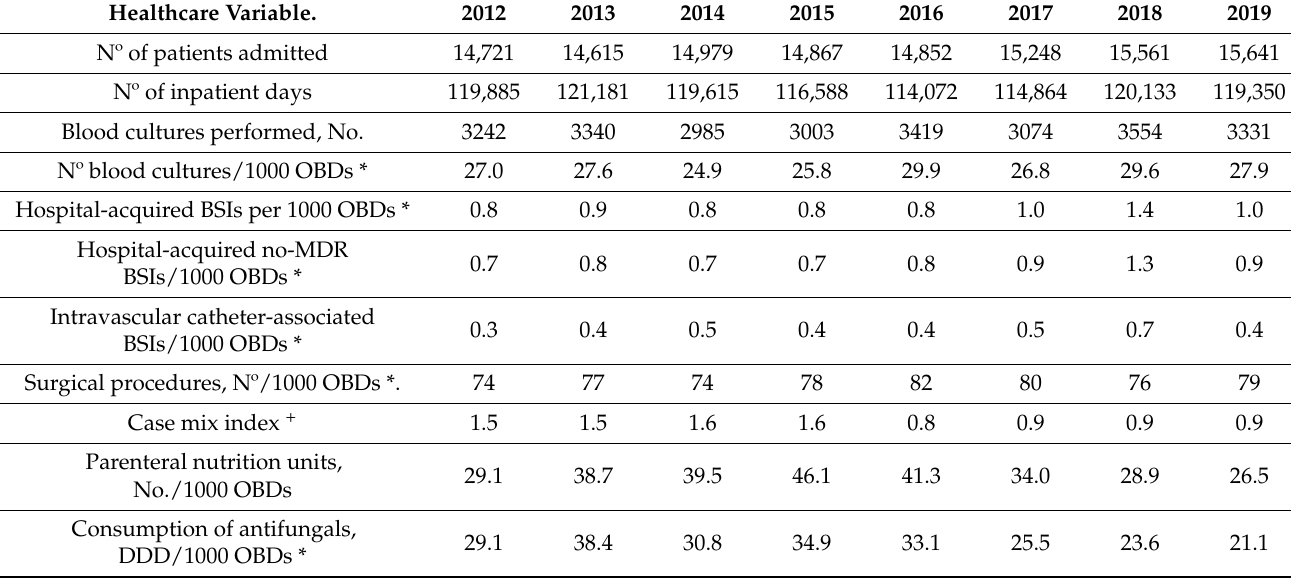
Table 3. Potential Changes in Healthcare during the Study Period by